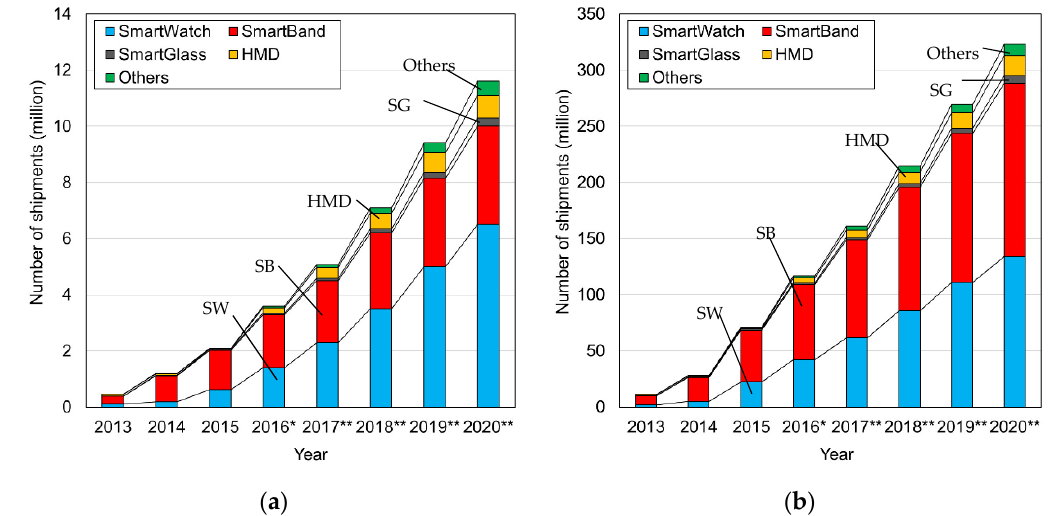
Figure 1. Market size and forecast of wearable devices for each year, (Source) Yano Research Institute Ltd., “Global Wearable Device Market: Key Research Findings 2016”, ( a ) Market size in Japan, ( b ) Global market size. * The value of market size figures in 2016 were expected. ** Market size figures after 2017 were forecasts. (HMD: Head-Mount Displays) [7].